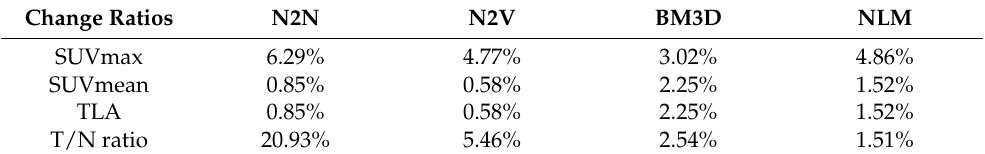
Table 4. The change ratios of SUVmax, SUVmean, TLA and T/N ratio for N2N, N2V, BM3D and NLM.